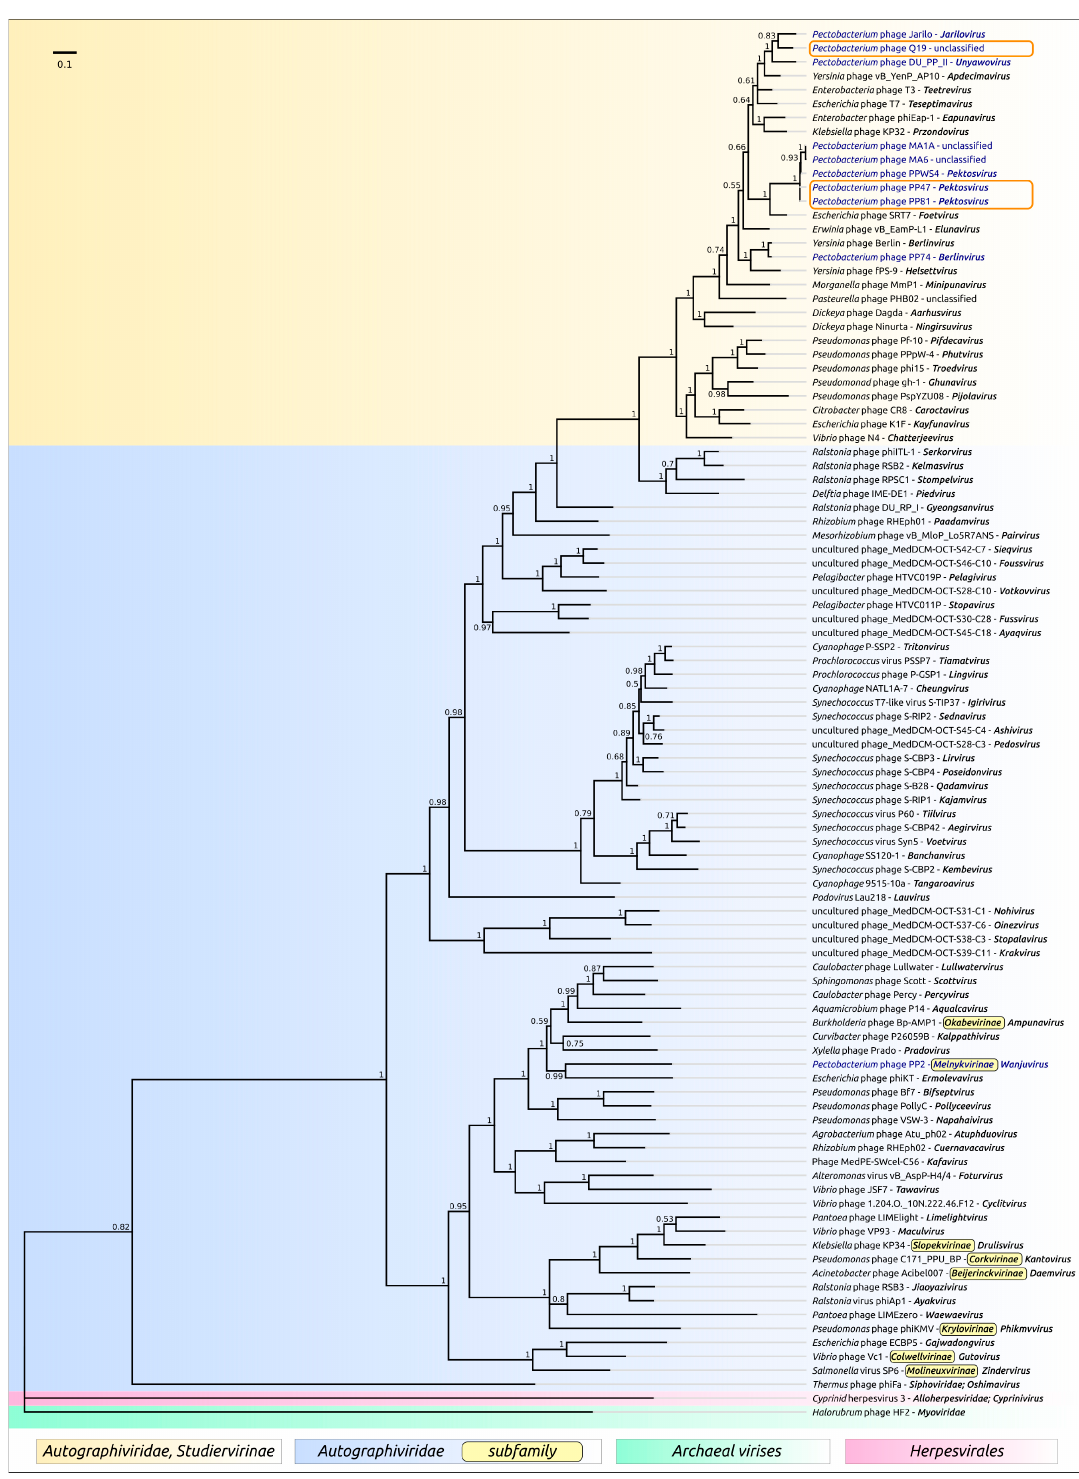
Figure 6. Phylogenetic tree obtained with MrBayes based on 100 terminase large subunit protein sequences. Bayesian posterior probabilities are indicated above their branch. Taxonomic classification is taken from ICTV and is shown to the right of the organism name. The scale bar shows 0.1 estimated substitutions per site and the tree was rooted to Cyprinid herpesvirus 3; of 2,000,000 generations, every 200 generations were sampled, with an average standard deviation of split frequencies of 0.012.